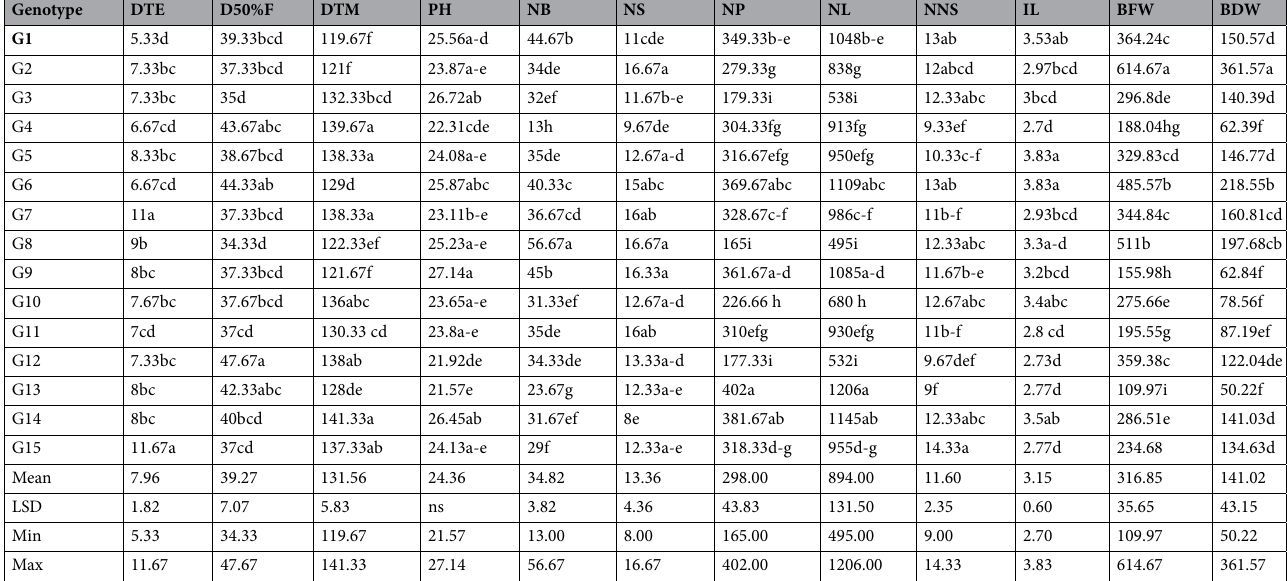
Table 4. The mean and mean comparison of 3 phenological and 9 vegetative traits of 15 Bambara groundnut accessions. Max maximum, Min minimum, C.V. coefficient of variation, LSD least significant difference at 5% level, DTE (day) days to emergence, D50%F (day) days to 50% flowering, DTM (days) days to maturity, PH plant height (cm), NB number of branches per plant, NS number of stems per plant, NP number of petioles per plant, NL number of leaves per plant, NNS no. of nodes per stem, IL (cm) inter nodes length, BFW (g) biomass fresh weight per plant, BDW (g) biomass dry weight per plant .